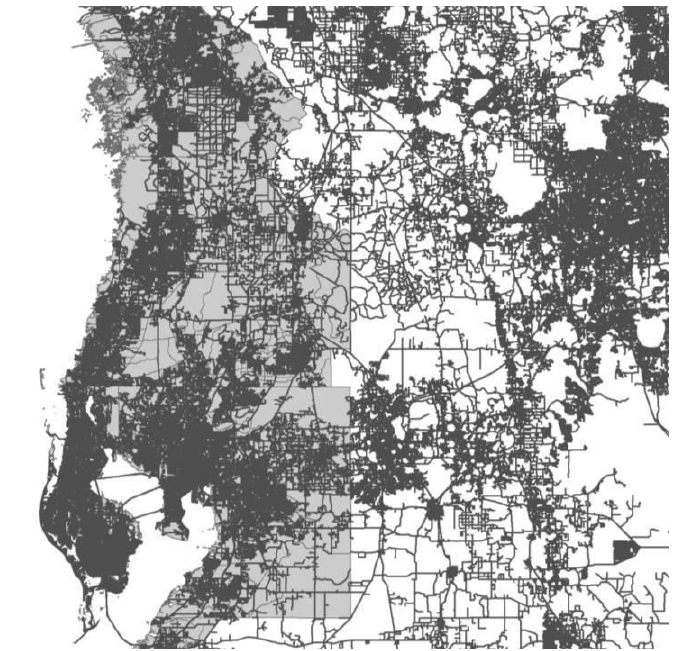
Figure 5 Navteq road data for the study